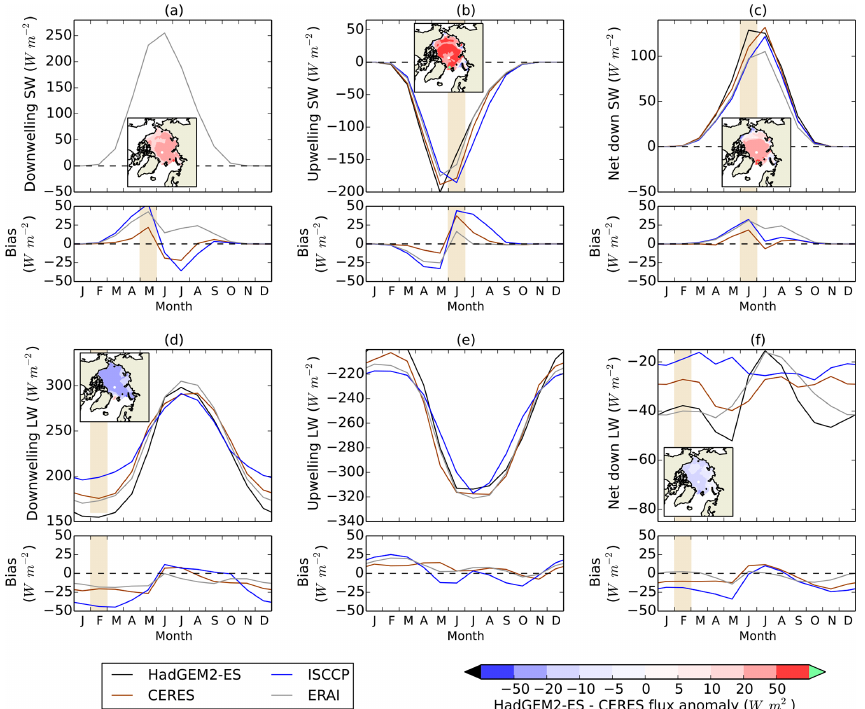
Figure 4. (a) Downwelling SW, (b) upwelling SW, (c) net down SW, (d) downwelling LW, (e) upwelling LW and (f) net down LW, for HadGEM2-ES 1980–1999 over the Arctic Ocean region, compared to CERES 2000–2013, ISCCP-D 1983–1999 and ERAI 1980–1999. (a) – (c) show absolute values. (d) – (f) show model bias relative to each respective dataset. For all fluxes, a positive number denotes a downward flux and vice versa. Maps of flux bias relative to CERES are shown for downwelling SW in May, upwelling and net down SW in June, and downwelling and net down LW in February.